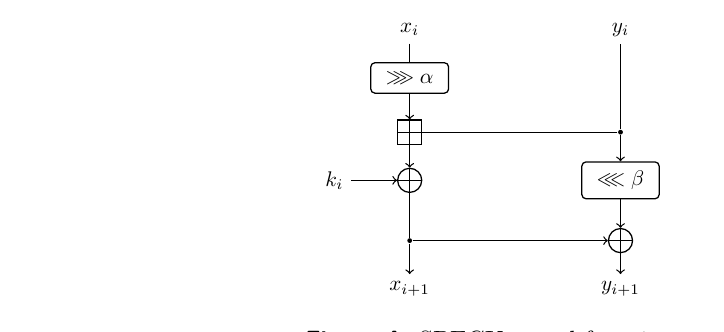
Figure 4: SPECK round function.